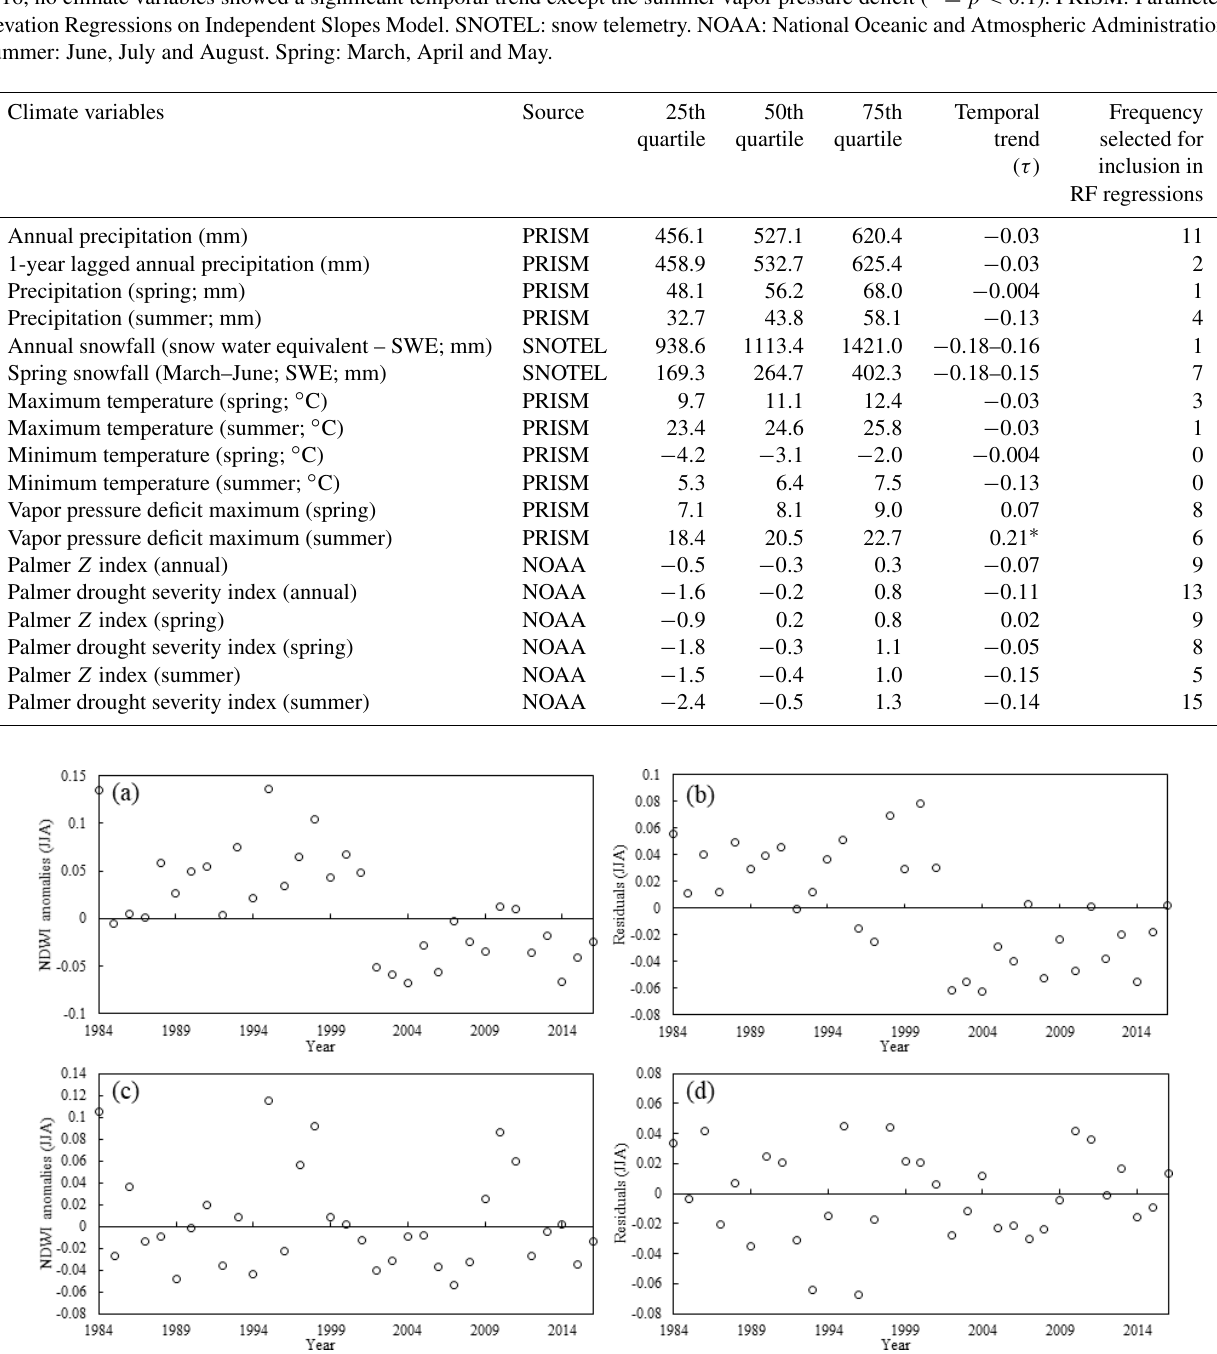
Table 4. Climate variables considered in the analysis to represent interannual variability in conditions. The 25th, 50th and 75th quartile are shown to indicate the variability in the per riparian reach values included in the random forest (RF) regressions ( n = 19). The frequency of variable selection for inclusion in the random forest regressions is also shown. When tested at a basin scale for the time period of 1984– 2016, no climate variables showed a significant temporal trend except the summer vapor pressure deficit ( ∗ = p < 0 . 1). PRISM: Parameter- elevation Regressions on Independent Slopes Model. SNOTEL: snow telemetry. NOAA: National Oceanic and Atmospheric Administration.